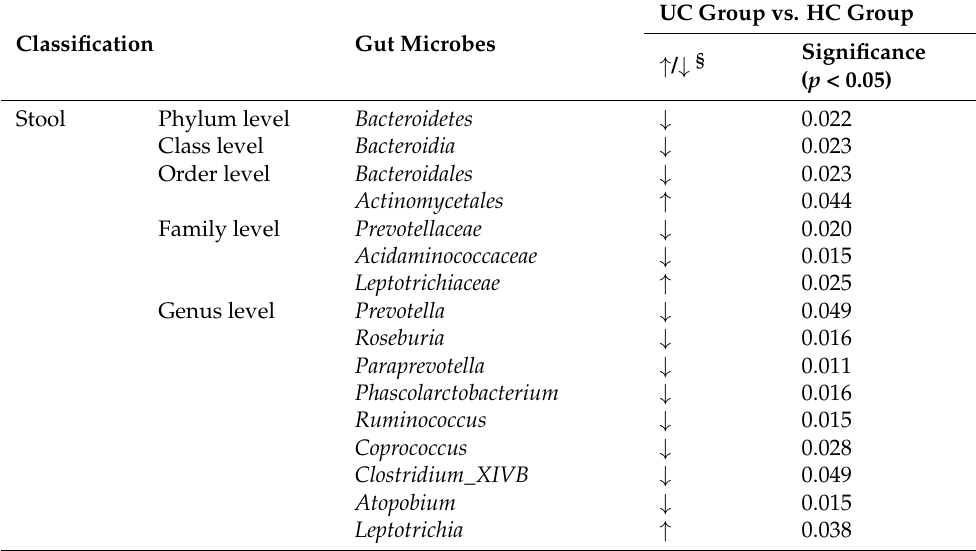
Figure 7. NMDS plots based on Bray-Curtis distances between the UC and HC groups. NMDS, non-metric multidimensional scaling; UC, ulcerative colitis; HC, healthy control; A2, ulcerative colitis patient group; C2, healthy control group. Table 2. Gut microbiota compositions according to taxonomic level in UC and HC